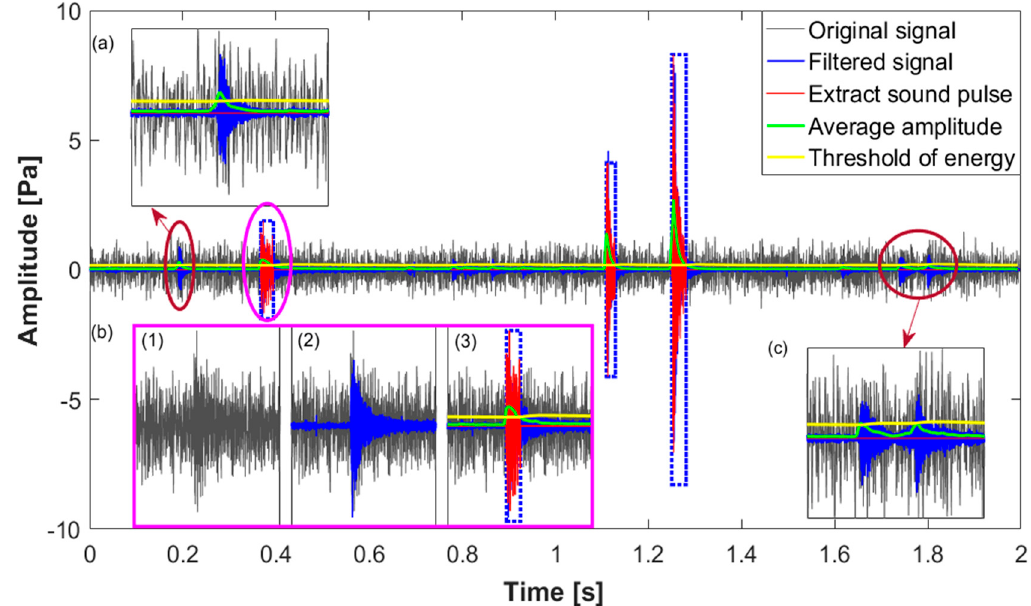
Figure 7. The cracked sound pulse extraction from the original AE signal. ( a ) Normal sound pulse with its duration less than the criteria; ( b ) cracked sound pulse covered up by significant background noise; (c) normal sound pulse with its average energy smaller than the threshold.